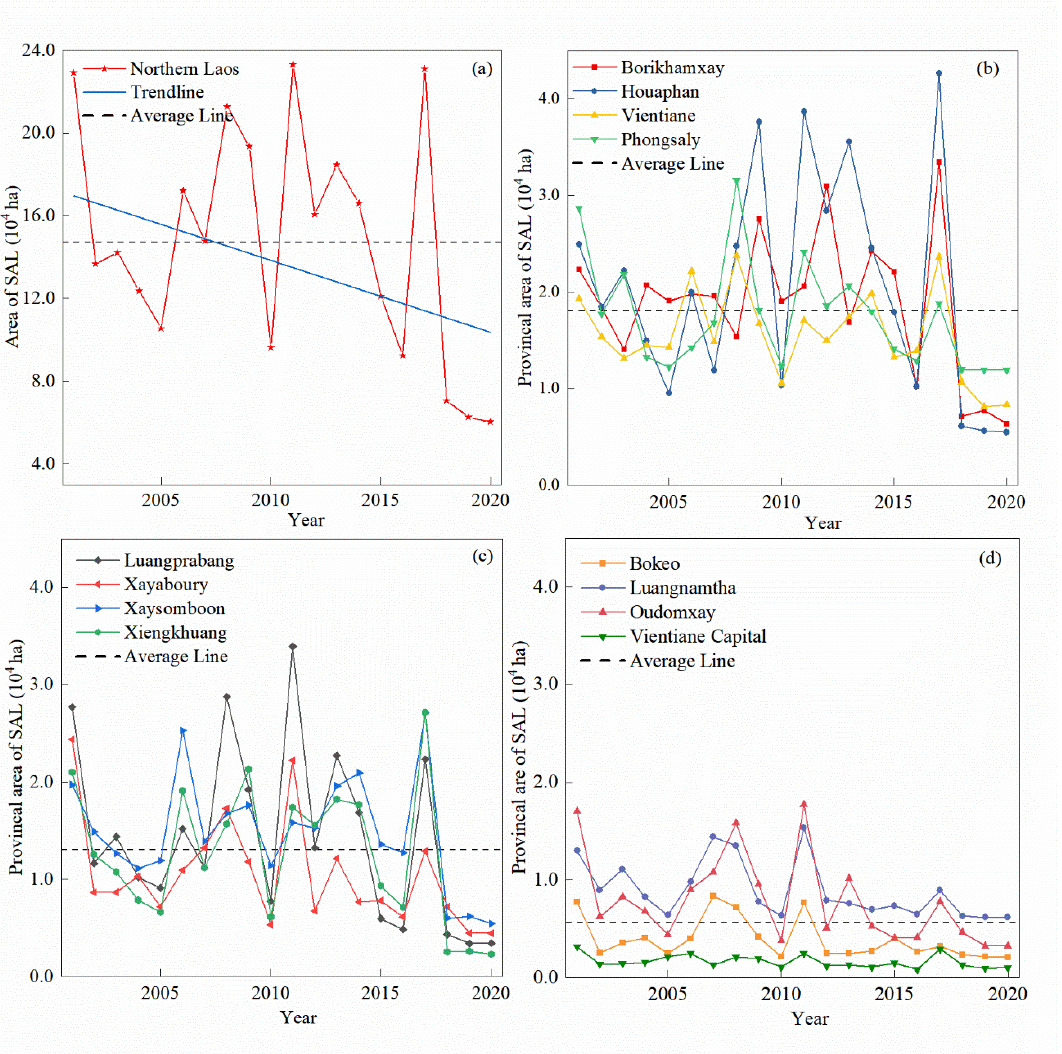
Figure 6. Annual changes in swidden agriculture landscape (SAL) in northern Laos and among provincial units during 2001–2020. Note that ( a ) refers to annual changes in SAL in the entire study area, while ( b – d ) represent those in four provinces in northern Laos